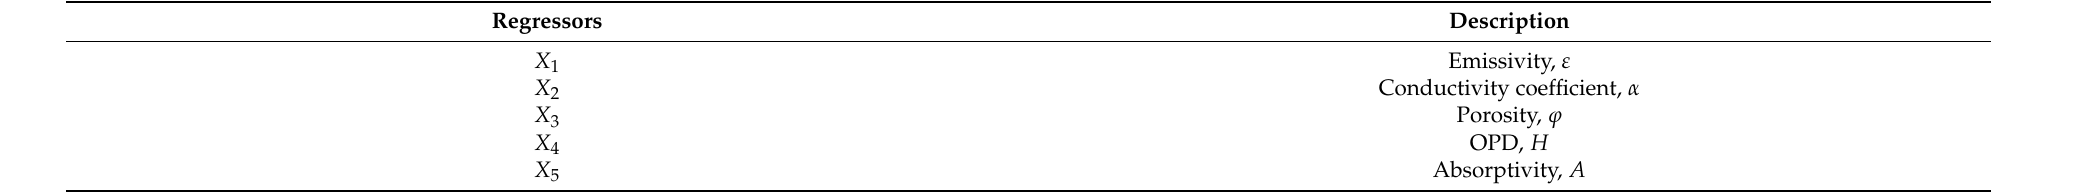
Table A4. Description of regressors for the thermal analysis parameters in Table 4.